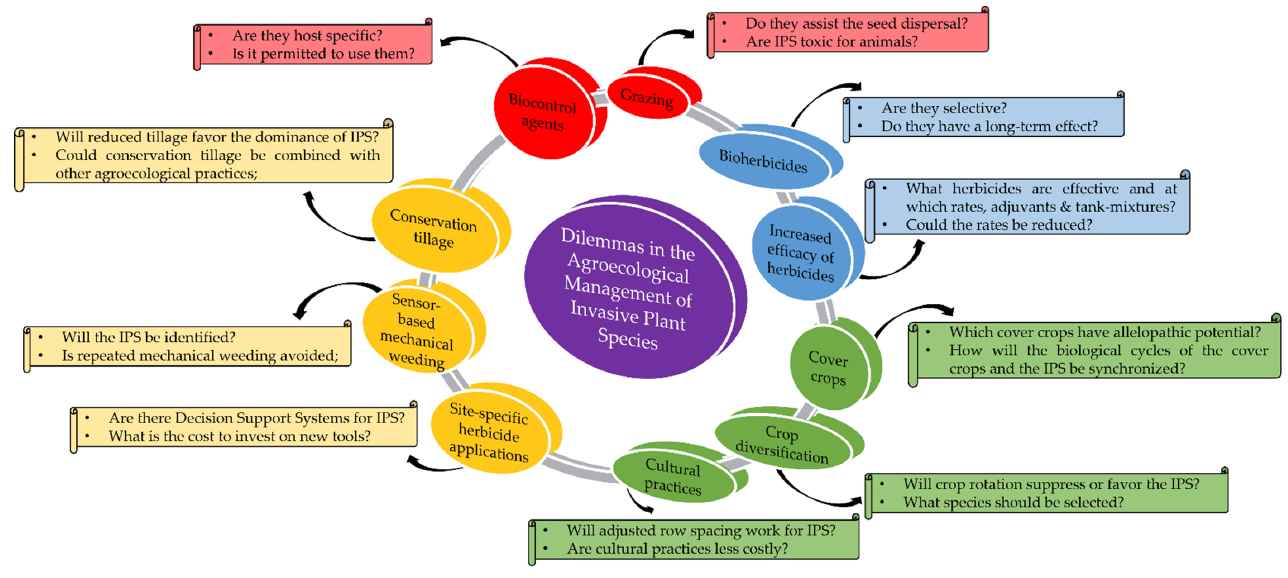
Figure 2. Dilemmas faced by farmers regarding the agroecological management of invasive plant species.